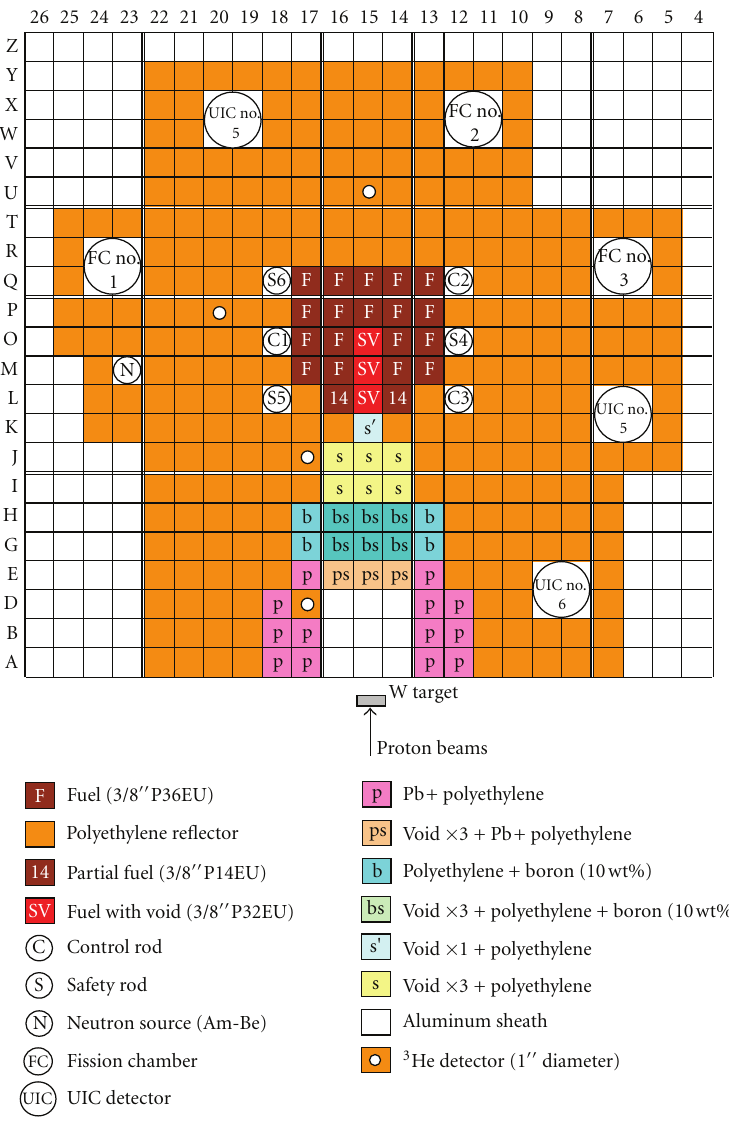
Figure 5: Top view of the KUCA A-core (A3/8 (cid:2)(cid:2) P36EU(3)) in the ADS